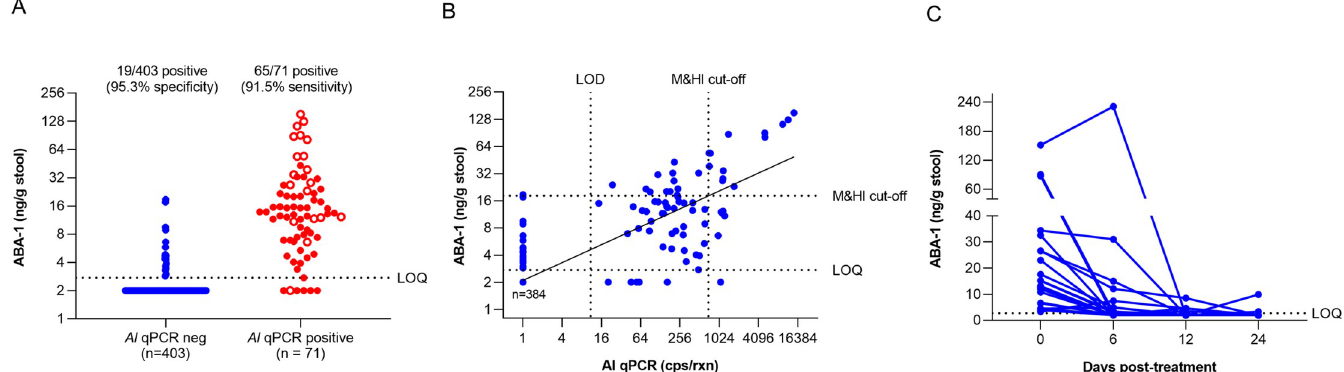
Fig 2. A. Assessment of ABA-1 coproantigen levels in stool samples from a cohort of 474 subjects collected in Kenya, stratified according to their A . lumbricoides qPCR result. Open circles indicate subjects with M&HI infection. B. Correlation between ABA-1 coproantigen levels and A . lumbricoides DNA detection in stool collected in Kenya (expressed in A . lumbricoides copies/reaction). Based on the linear regression, a cut-off of 18.4 ng/g stool was defined to identify subjects with M&HI infection. Moderate infection was defined as > 700 cps/rxn (see Materials and Methods). C. Effect of treatment with albendazole on the presence of ABA-1 in stool. Stool samples were collected before (Day 0) and at different timepoints (6, 12 and 24 days) after treatment with